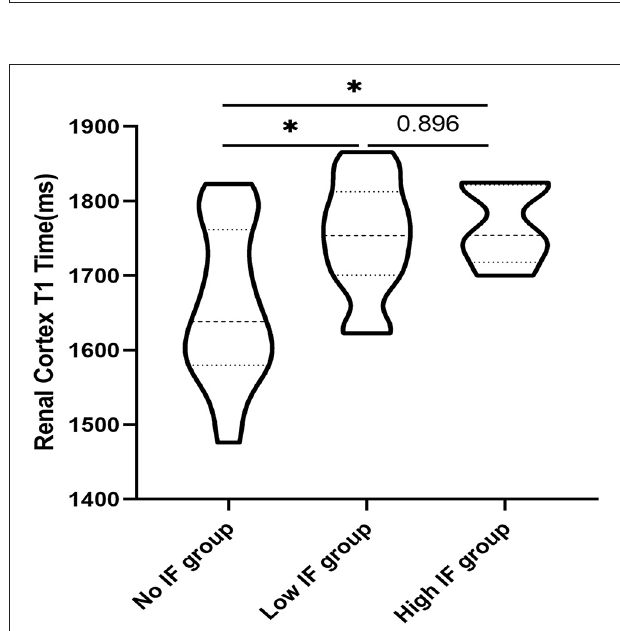
FIGURE 7 | Comparison of T1 values in the renal cortex of patients with different degrees of IF. T1 values in the renal cortex of the no IF group were lower than those of the low and high fibrosis groups (* P < 0.05), while T1 values in the renal cortex of the low and high fibrosis group had no significant difference ( P >